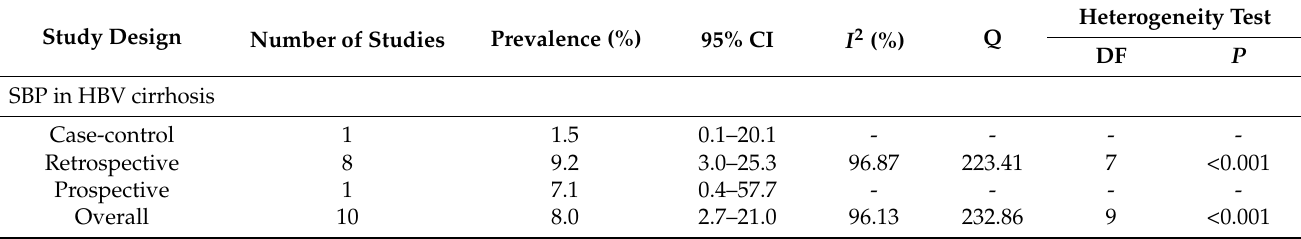
Table 5. Subgroup analysis of SBP in three different viral hepatitis-related liver cirrhosis with the study